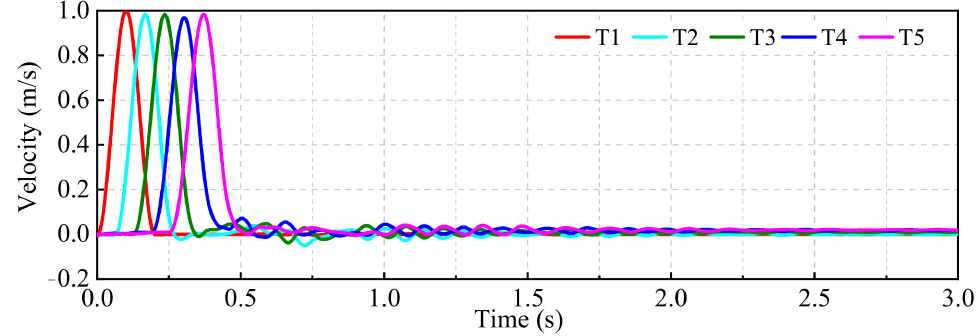
Figure 6. Horizontal velocity history of measuring points under the pulse wave with right reflect- ing